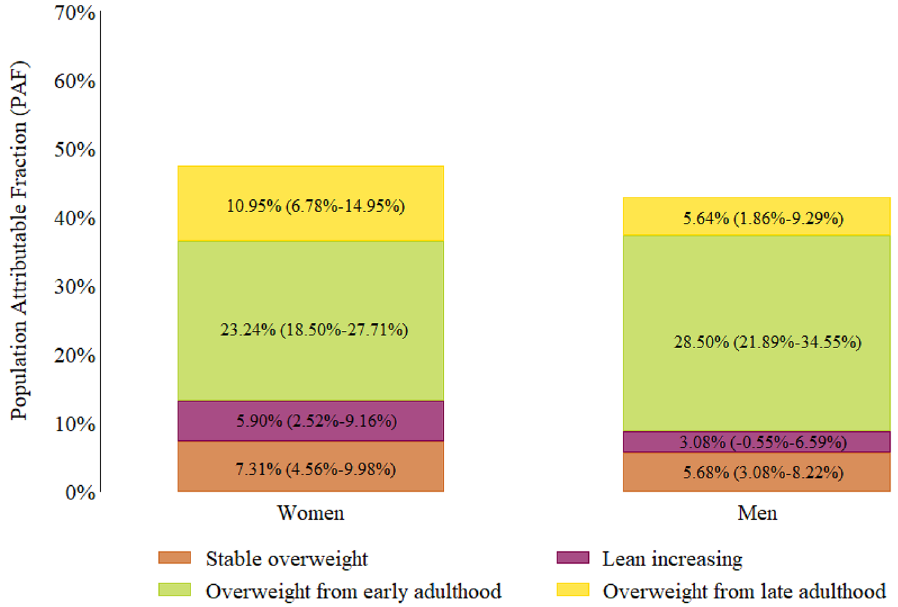
Figure 3. Population attributable fractions (PAF) of trajectory groups by sex. Compared to the stable normal trajectory group, the overall proportion of type 2 diabetes cases attributable to any of the life-course weight trajectories was 47.40% (95% CI 38.06–55.34%) for women and 42.91% (95% CI 31.47–52.45%) for